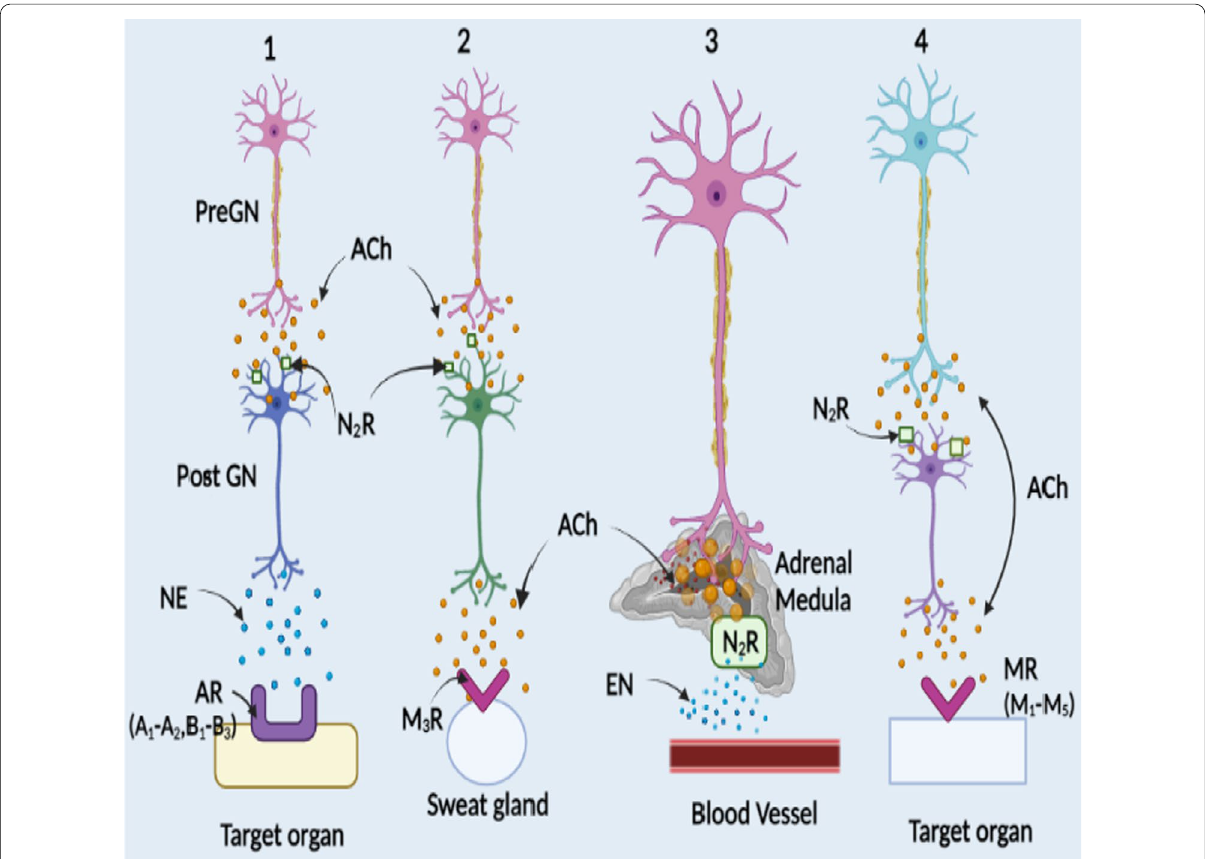
Fig. 4 Autonomic nervous system and location of receptors. Nerves of autonomic nervous system (ANS) extend from central nervous system (CNS) to cardiac muscle, smooth muscle, organs and glands by preganglionic (Pre GN) and postganglionic (Post GN) neurons. PreGN releases acetylcholine (ACh) into the synaptic cleft and get bind to nicotine receptors (NR) in Post GN. Depolarization of membrane results in action potential which on arriving at the axon terminal releases neurotransmitter: ACh, norepinephrine (NE) or epinephrine (EN) in the synaptic cleft. The binding of neurotransmitter to the receptors: Androgenic (AR) or muscarinic (M) on the target organ results in excitation or inhibition. (1–3) Sympathetic system, (4) Parasympathetic system. These two systems differ in the type of neurotransmitter released, type of receptors and secondary messengers expressed [Prepared using